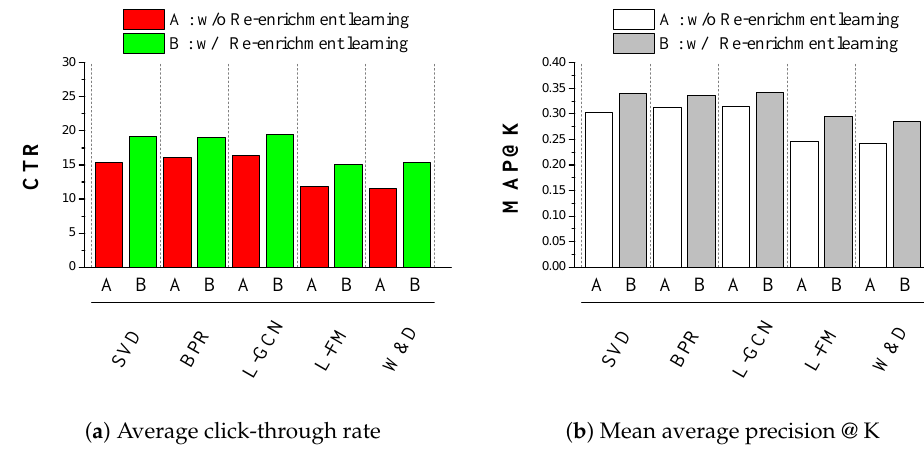
Figure 8. Visualization of A/B experiments on the Amazon